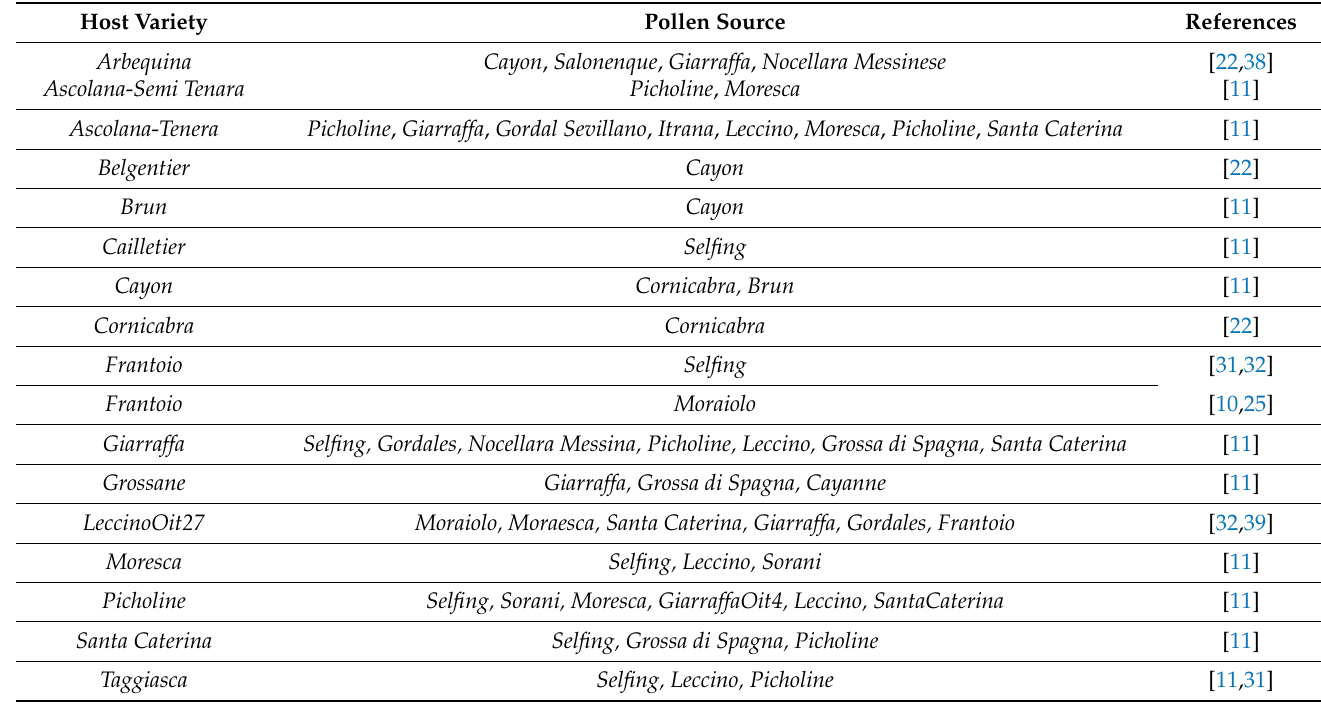
Table 1. Crosses between host varieties G1 × pollen source G1 reported to have given fruits or embryos.